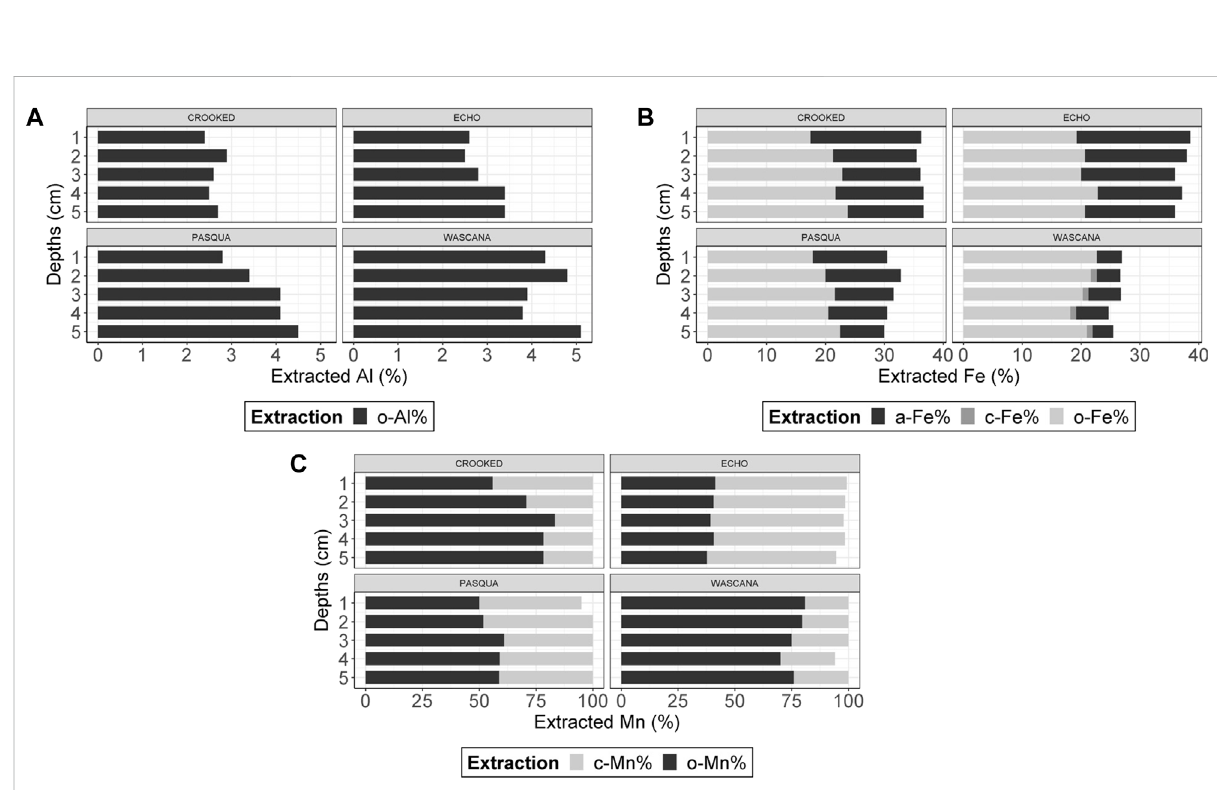
FIGURE 4 Extracted metal cation phase concentrations of (A) organically-complexed aluminum (o-Al) as a percentage of the total Al; (B) organically- complexed iron (o-Fe), amorphous Fe (a-Fe) and crystalline Fe (c-Fe) as percentages of the total Fe; and (C) organically-complexed manganese (o-Mn) and crystalline Mn (c-Mn) as percentages of the total Mn in sediments by depth (ranging from 0 – 5-cm); n = 5 depth samples per lake, (no duplicates were